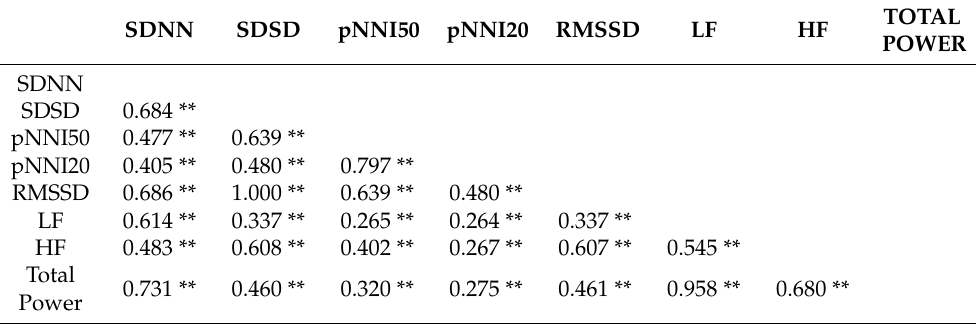
Table 5. Correlation coefficients among heart rate variability parameters.